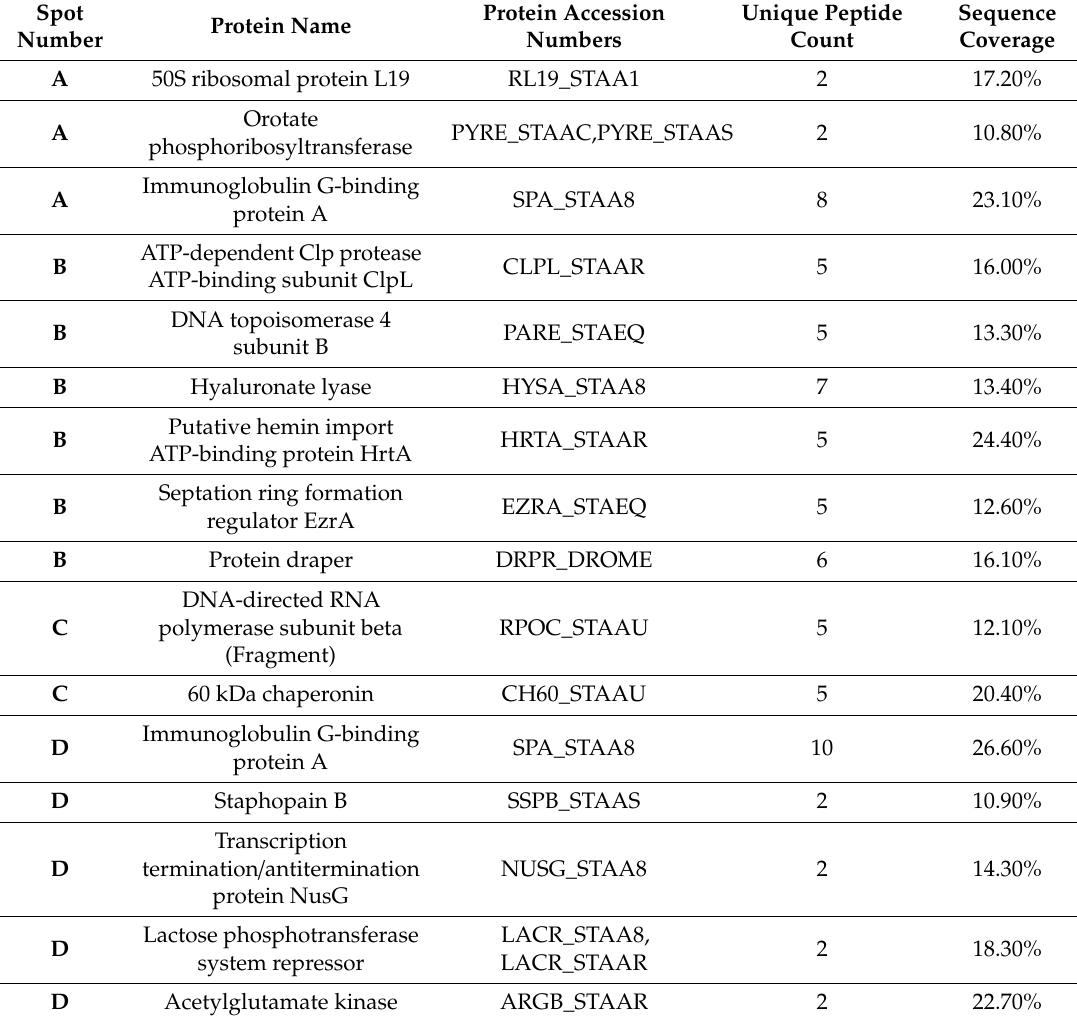
Table 2. List of proteins identified by searching a S. aureus reference proteome